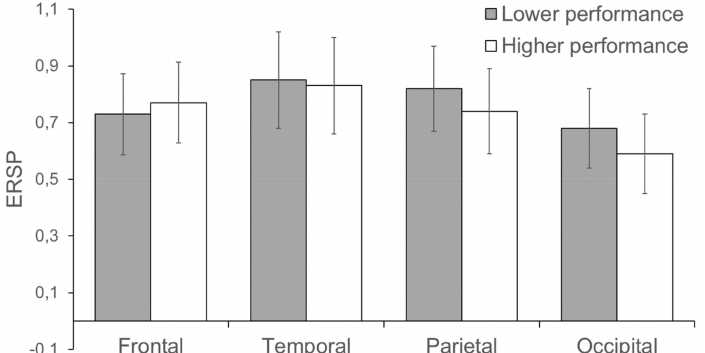
Figure 1. Averaged event-related spectral perturbations (ERSP) scores in the range from 7 to 17 Hz in the time interval from the beginning till 200 ms after the stop signal presentation in groups with performance lower than a median (gray color) and higher performance above the median (white color). Vertical lines reflect the standard error.